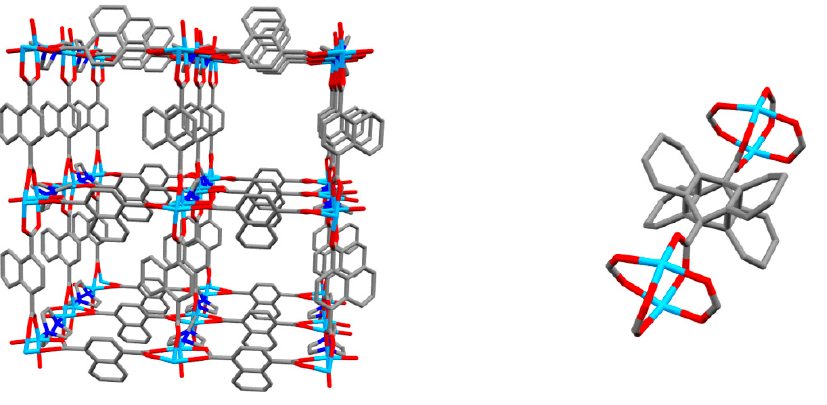
Figure 3. Structure of pillared DMOF with 1,4-NDC rotors. Adapted with permission from [26]. Copyright Wiley-VCH, 2006.